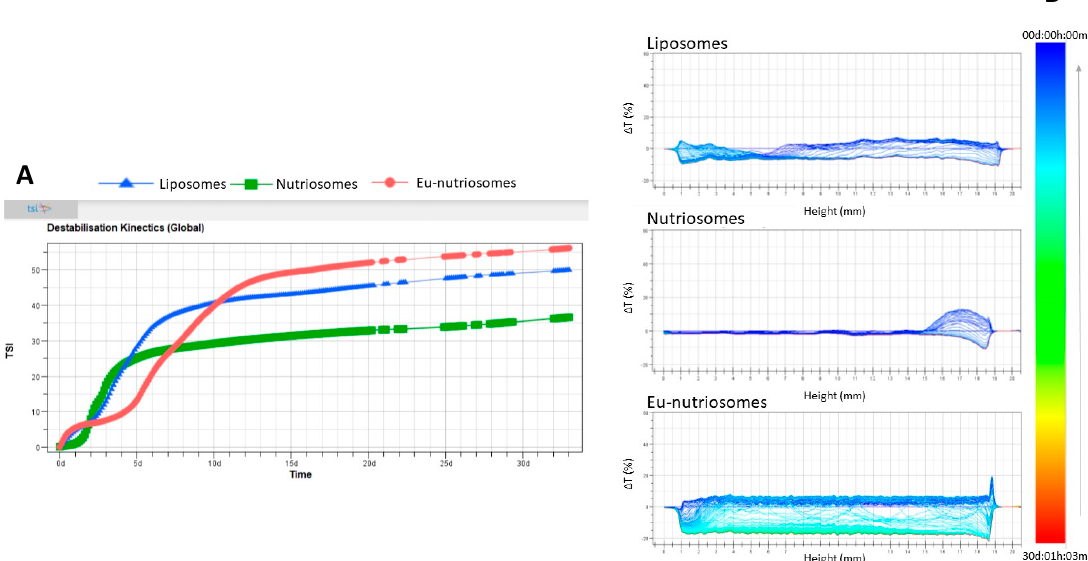
Figure 2. Evolution of Turbiscan ® Stability Index (TSI) for ascorbic acid and tocopherol co-loaded liposomes, nutriosomes and EU-nutriosomes over 30 days at 25 °C ( A ). Turbiscan ® Δ T profiles for ascorbic acid and tocopherol co-loaded liposomes, nutriosomes and EU-nutriosomes over 30 days at 25 °C ( B ).